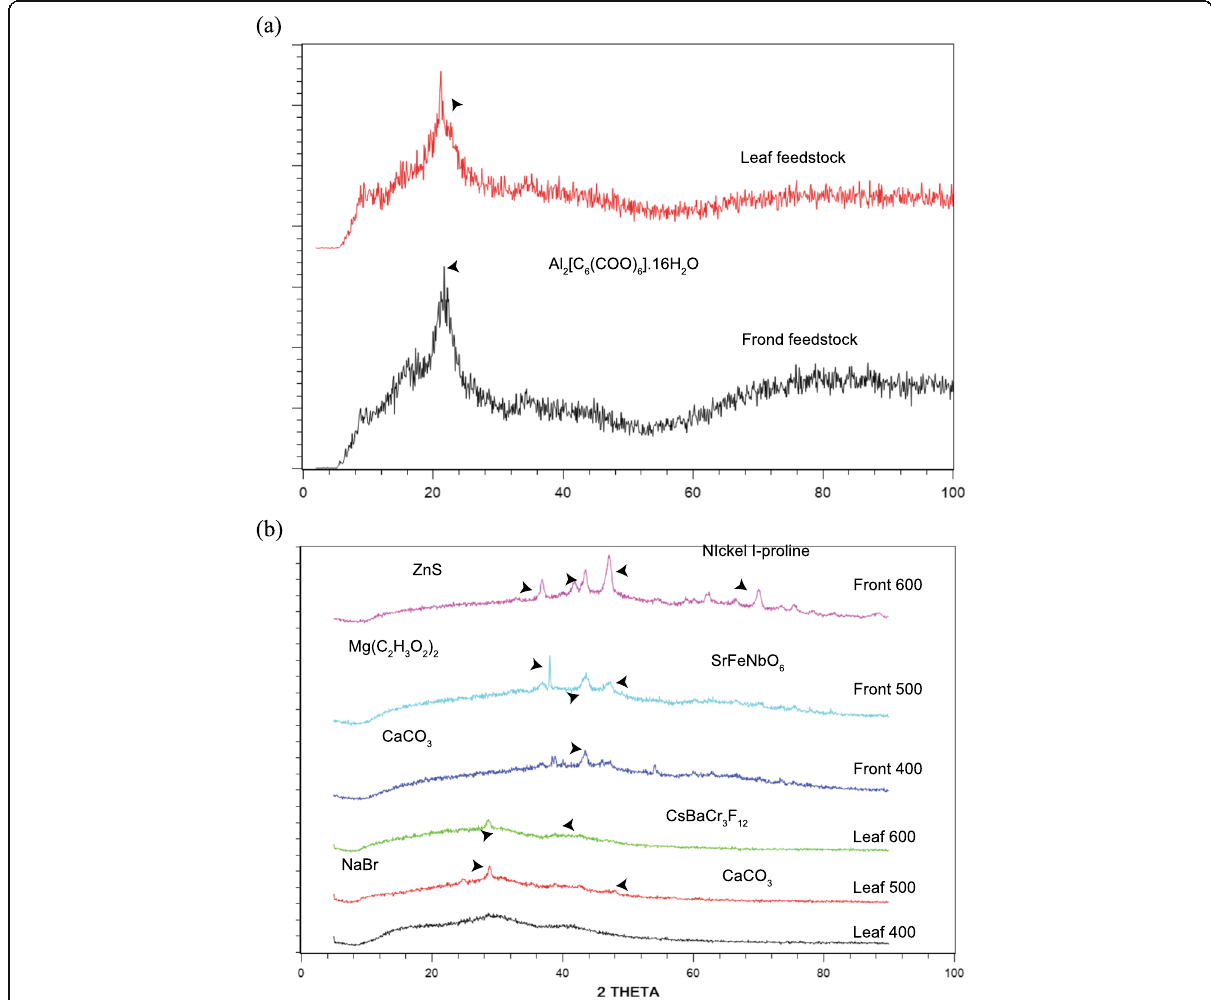
Fig. 4 XRD spectra of a leaf-frond feedstocks and b leaf-frond biochar